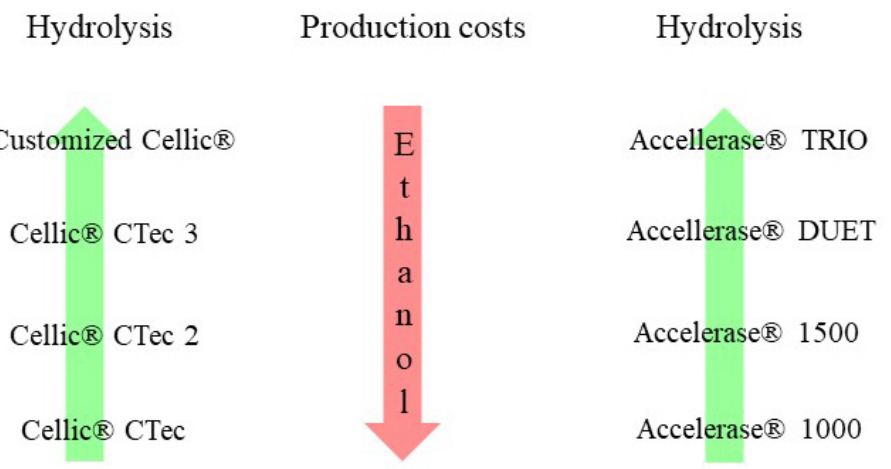
Figure 1. Improved hydrolysis of lignocellulosic biomass using Cellic ® family and Accelerase ® family, while decreasing the production costs of cellulosic